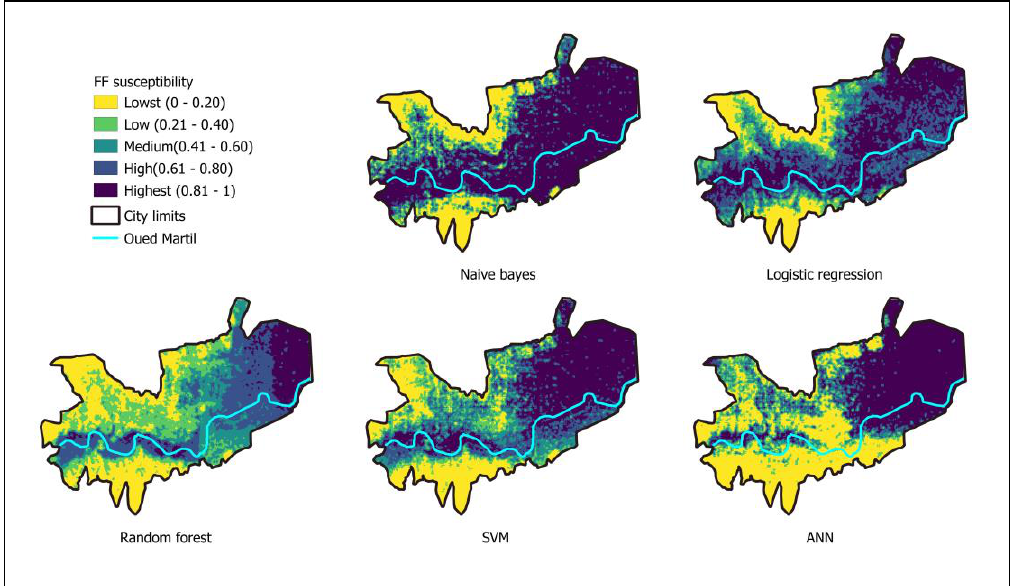
Figure 4 : Flood susceptibility maps using NB , LR , RF , SVM and ANN